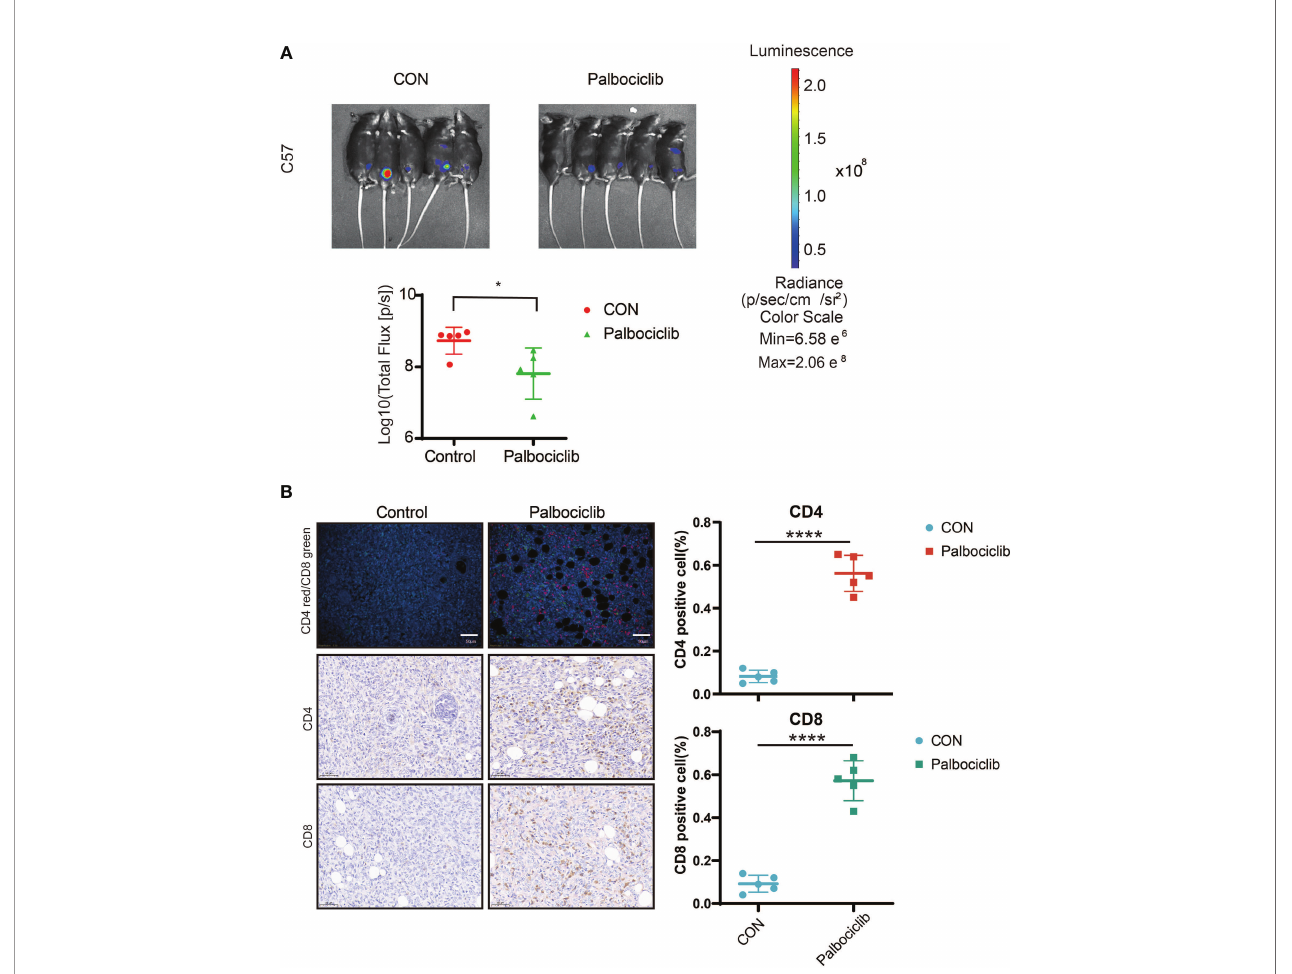
FIGURE 8 | CDK4/6 inhibitor palbociclib suppresses tumor growth through activating immune microenvironment in vivo. ( A ) Luciferized ID8 xenograft models could reproducibly respond to the vehicle and Palbociclib could be serially followed by BLI imaging. Mice with established BLI signals were treated with 4 weekly treatments for vehicle (5% DMSO + 30% PEG300 + 5% Tween80 + ddH2O), Palbociclib (20 mg/kg, oral gavage, per day). All measurements are represented as Mean + SD. The p values were calculated using the Student t-test: *P < 0.05. (B) Representative images of IF/IHC with CD4/CD8 in Control and Palbociclib, red indicated CD4 + cells, green indicated CD8 + cells (Left), Scale bar, 20 m m. Positive cell (%) of indicated cells in right. Student ’ s t-test: ****P